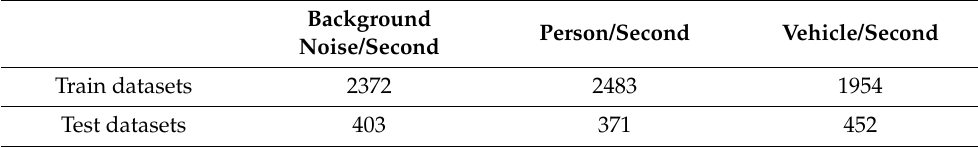
Table 3. Size of